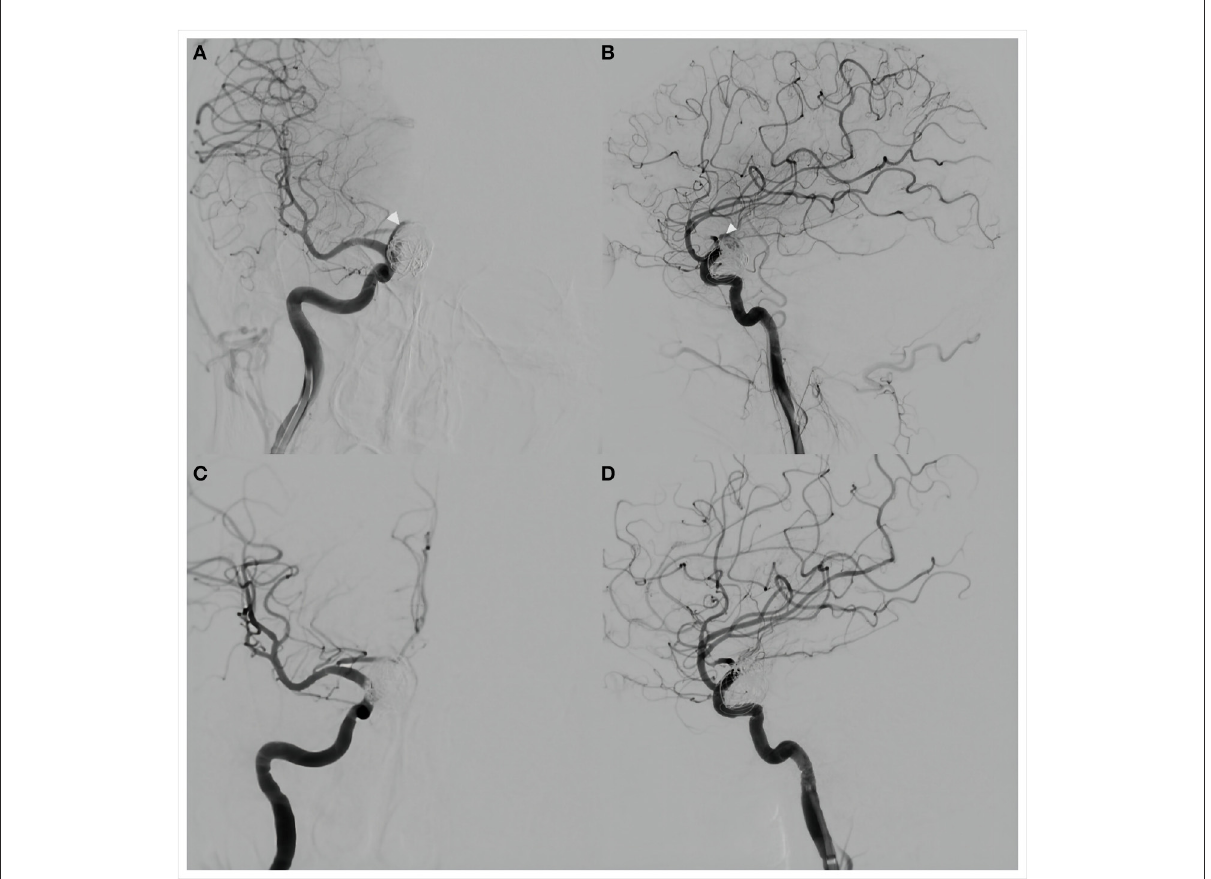
FIGURE3 Anteroposterior (A) and lateral (B) views of cerebral angiography showed a small amount of blood flow into the aneurysm lumen (white arrows), suggesting delayed aneurysm rupture. Placement of a Willis covered stent (MicroPort, Shanghai, China) was then performed. Anteroposterior (C) and lateral (D) views of angiography performed immediately after the procedure showed no residual blood flow in the aneurysm lumen. The internal carotid and anterior choroidal arteries were